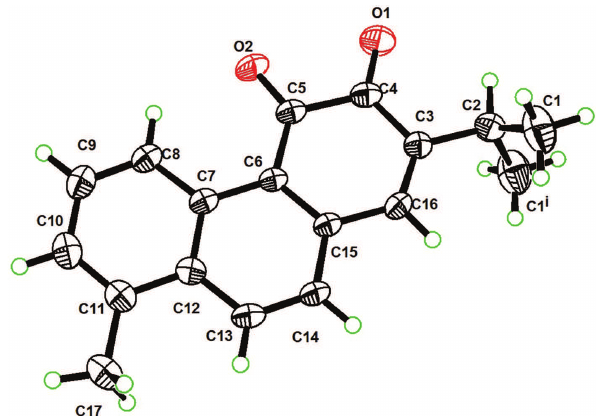
Table 2: Fractional atomic coordinates and isotropic or